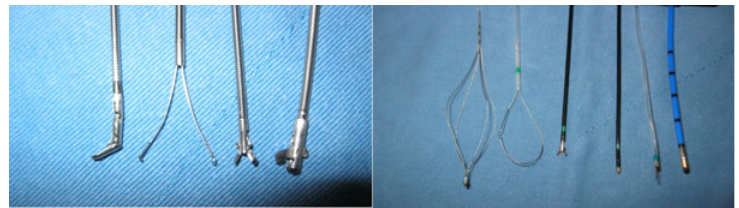
Fig 1. The multiple modalities of the flexible bronchoscopy included forceps, basket, loop, coagulation forceps, coagulation knife, and probe for cryotherapy.